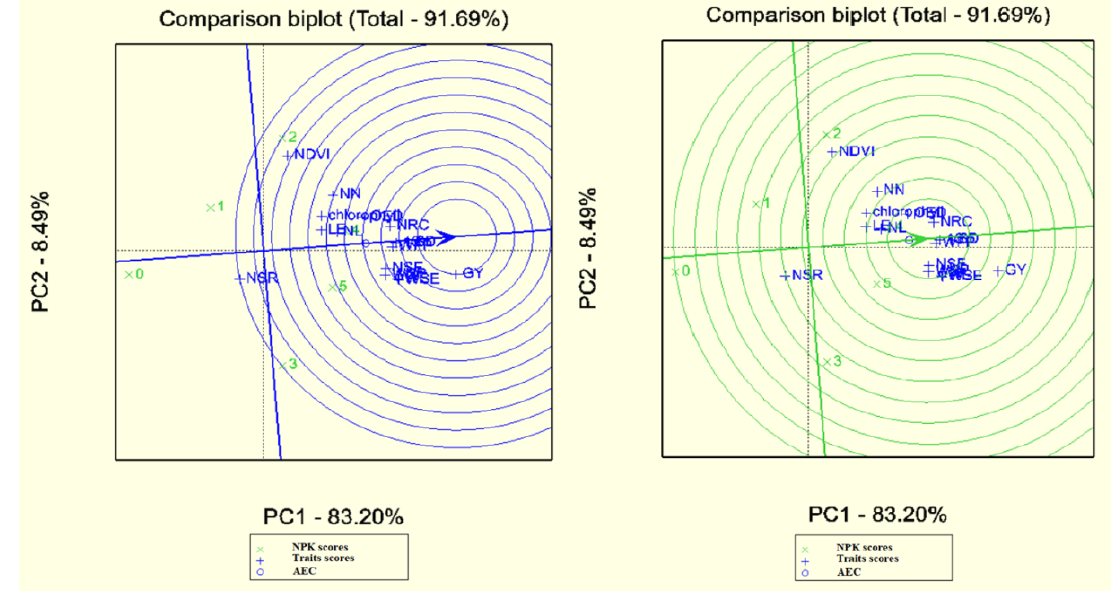
Figure 5. Determination of ideal traits and treatments with GGE biplot on FAO410. Chlorophyll (Chl), NDVI (NDV), plant